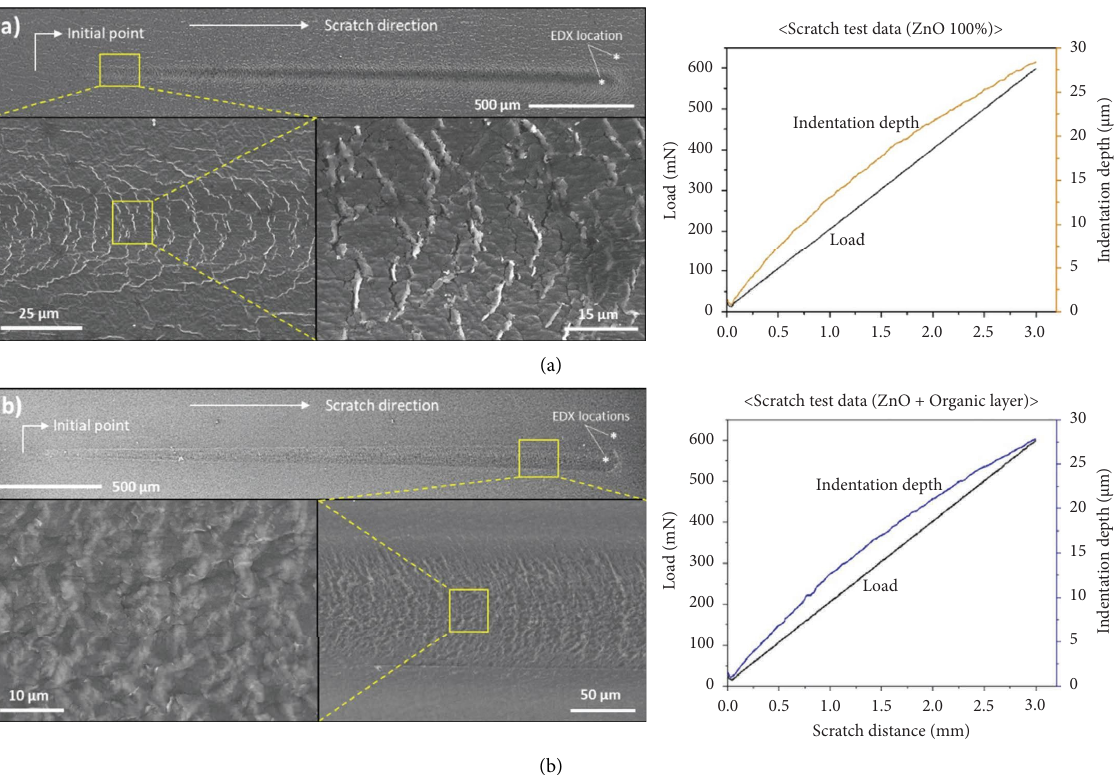
Figure 3: SEM images and load-deformation curves of scratch tests for (a) pure and (b) hybrid ZnO flms are shown. Locations of EDX measurements for atomic ratios in and outside of the scratch tracks were indicated by star ( ∗ ) symbols.